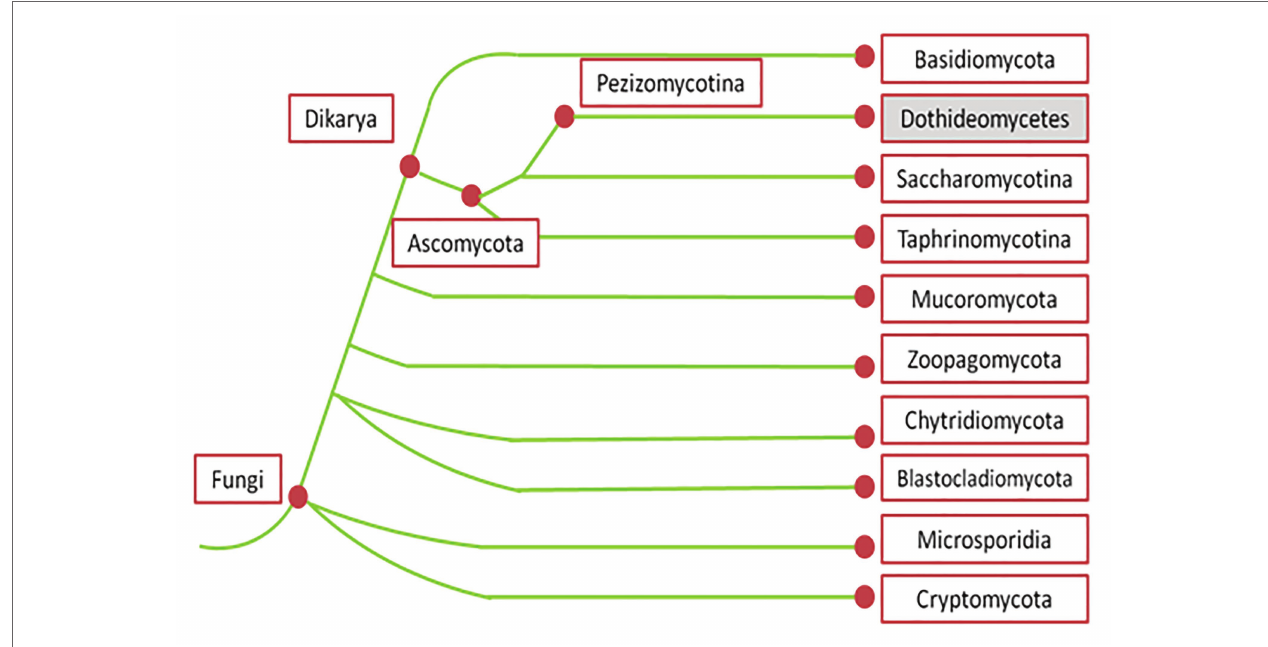
FIGURE 1 | Phylogenetic tree of fungi according to MycoCosm portal (adapted from Grigoriev et al., 2014). According to this phylogenetic tree, Pyrenophora teres belongs to the kingdom Fungi , phylum Ascomycota , subphylum Pezizomucotina , and class Dothideomycetes .